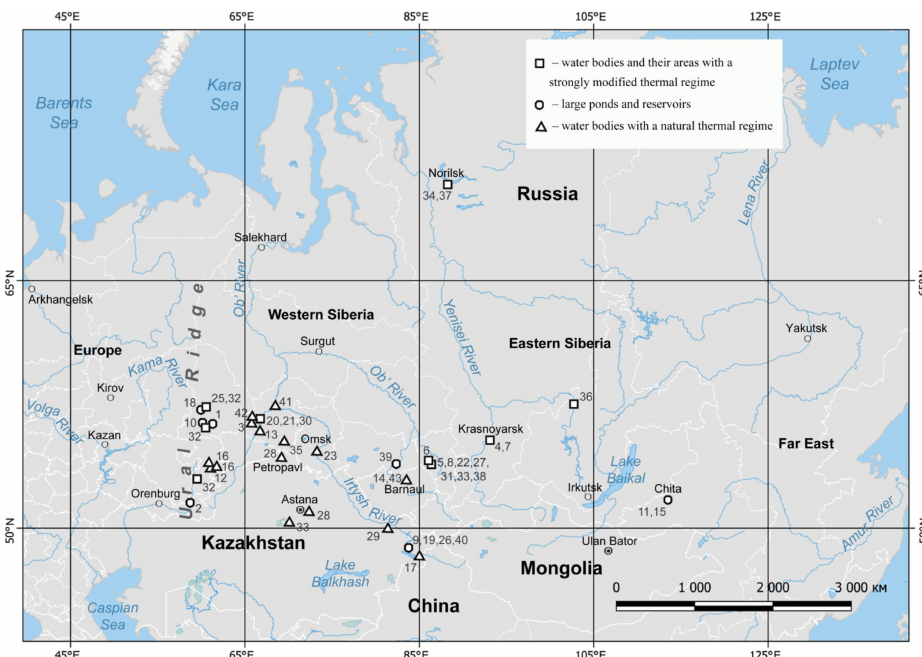
Figure 1. Map of neobiotic freshwater species of Mollusca first occurrences in Siberia. Numbers indicate the localities, which correspond to those in Table